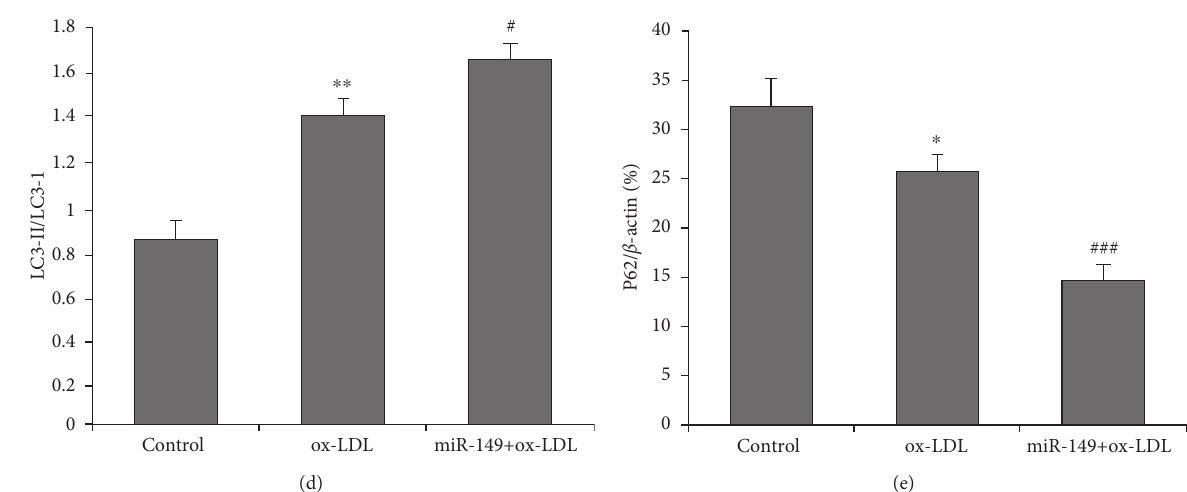
Figure 2: Effect of miR-149 mimics on autophagy in ox-LDL-induced HUVECs. (a) HUVECs of control, ox-LDL, and miR-149 mimics were stained with LC3-II antibody (green, magnification × 100). The nucleus was stained with DAPI (blue). (b) Quantification of LC3-II fluorescence intensity, as presented by cells with LC3-II dots. miR-149 mimics significantly increase the number of cells with LC3-II dots. (c) Western blot was performed to determine LC3-I, LC3-II, and P62 proteins. (d) miR-149 mimics significantly increases the ratio of LC3-II to LC3-I. (e) miR-149 mimics significantly decreases the P62 protein expression. ∗∗∗ P < 0 . 001 vs. control group; # P < 0 . 05, ## P < 0 . 01, and ### P < 0 . 001 vs. ox-LDL